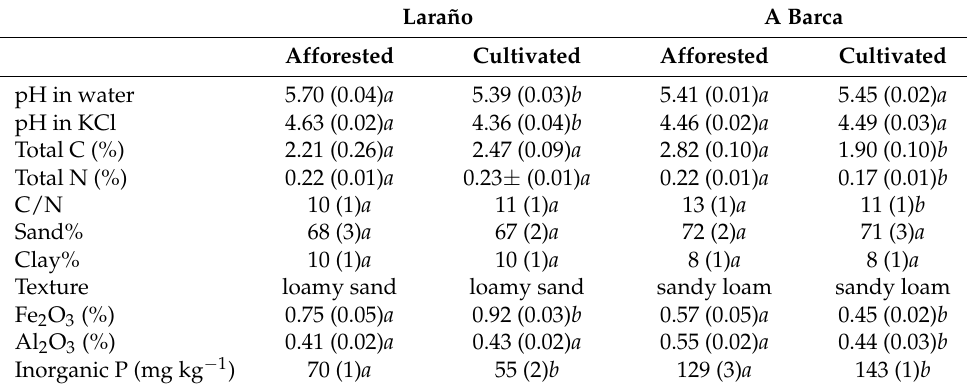
Table 2. Main physical and chemical properties of the soils (0–30 cm) obtained at the same time as the plots were sampled to estimate the C stocks (in the 2010 year). Values are means and standard deviation, in brackets (n = 3). Different letters indicate significantly different mean values between sites ( p <